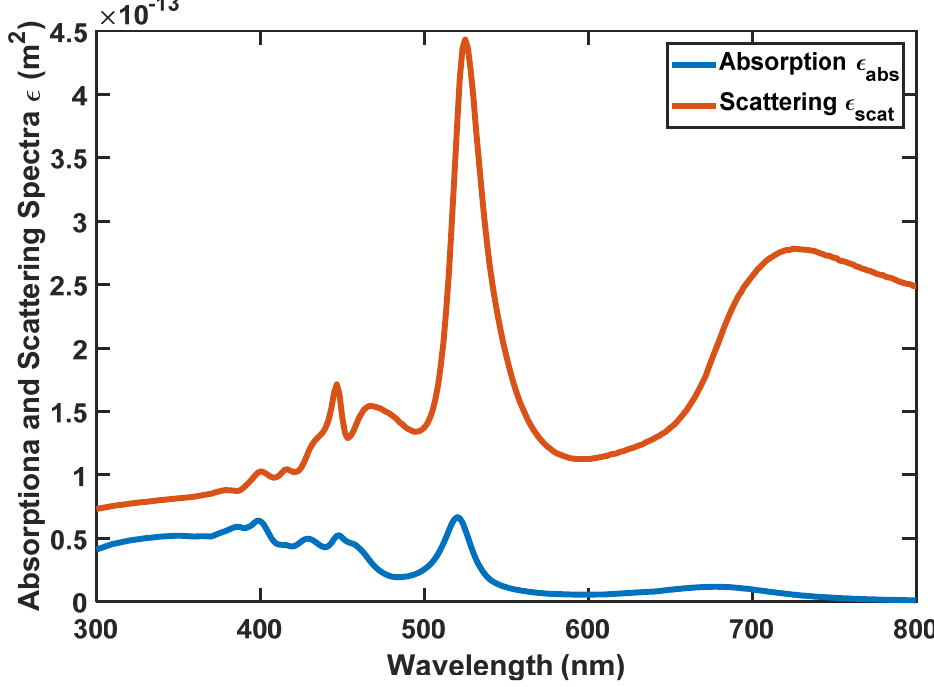
Figure 13. Absorption and scattering spectra of SiO 2 /Si nanoparticle with R = 85 nm.